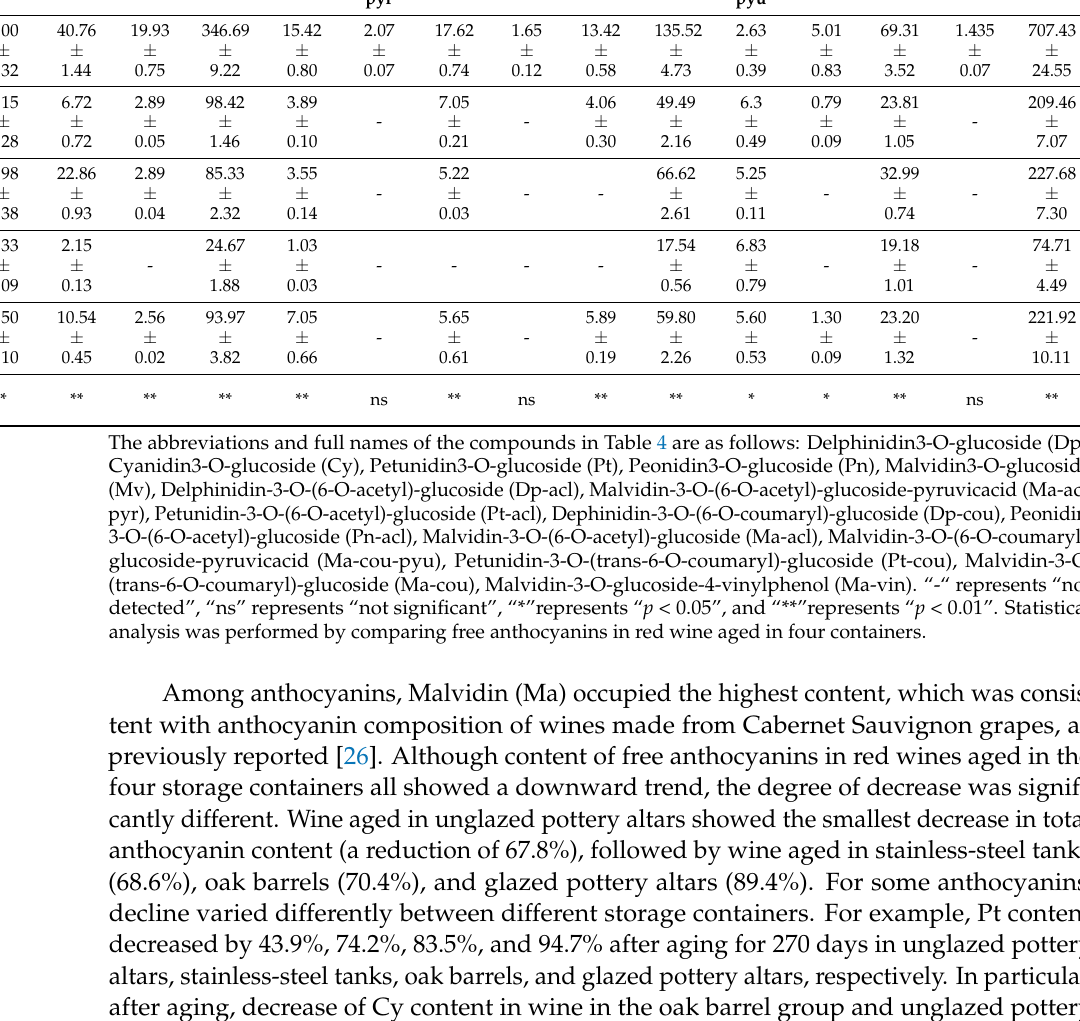
Table 4. Types and contents of free anthocyanins in red wine aged in different containers (mg/L).